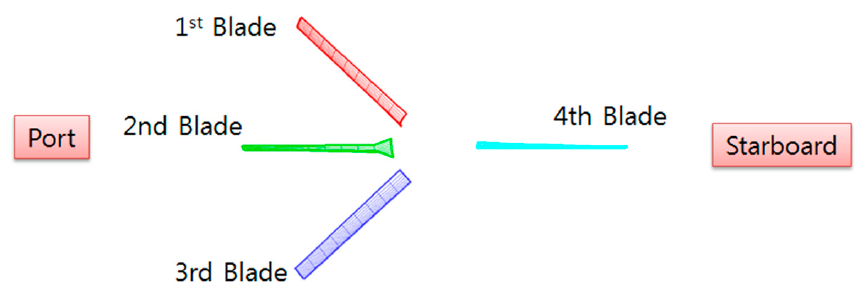
Figure 11. Blade position of each blade of pre-swirl stator. Table 6. Geometry of ring stator according to radius.